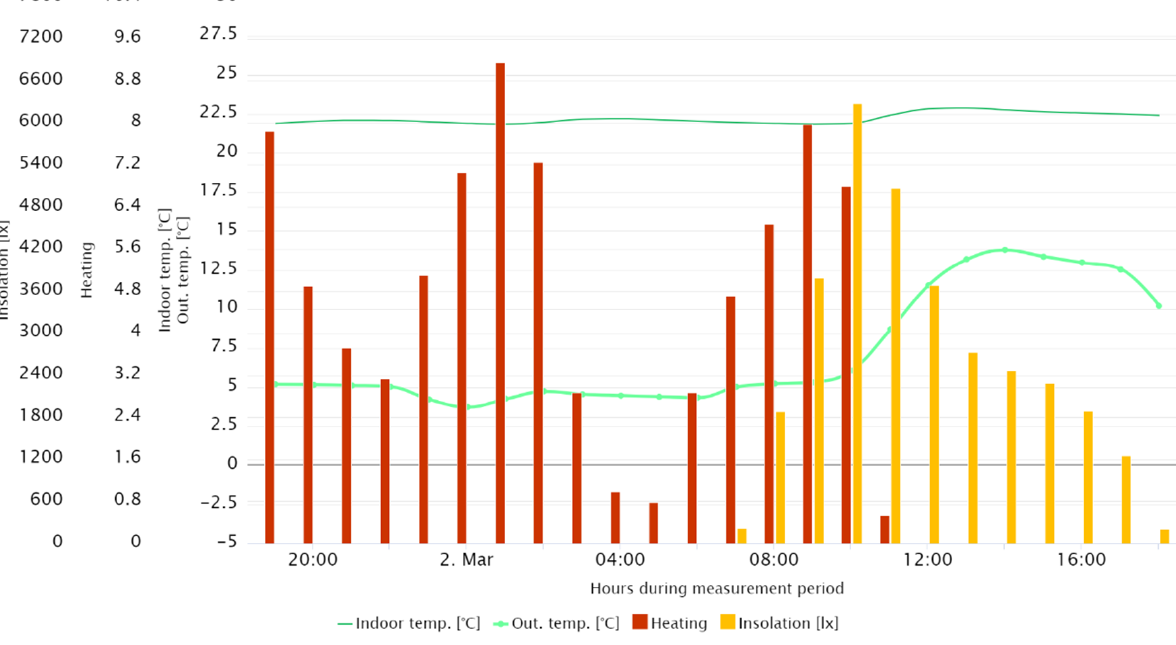
Figure 11. Twenty-four-hour period hourly averages of internal temperature for room 124 referring to heating valve position, insolation, and outdoor temperature.